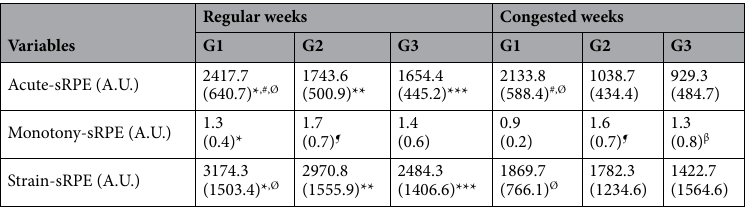
strain-TD; acute-HIR, monotony-HIR, strain-HIR; acute-Acc, monotony-Acc, strain-Acc; Acute-Dec, Monot- ony-Dec, Strain-Dec. Statistical analysis. The Kolmogorov–Smirnov and Levene tests were used to check the normality of the data distribution and homogeneity of variance, respectively. Data are presented as mean and standard devia- tion (SD). A multivariate general linear model was used to verify the independent and interactive effects of the fixed factors (i.e., match schedule, congested vs. regular weeks; matches’ participation, G1 vs. G2 vs. G3) on the internal and external measures (dependent variables). The Bonferroni test was used to verify the pairwise dif- ferences. The level of significance was pre-fixed in 5% ( p < 0.05). The playing positions (i.e., central defenders, external defenders, central midfielders, external midfielders, forwards) were computed as a covariate. The mag- nitude of differences was tested using the standardized effect size (ES) of Cohen (d), following the thresholds 24 : 0.0–0.20, small; 0.21–0.50, medium; 0.51–0.80, large, > 0.8 very large. The partial eta squared (η 2 ) was classified